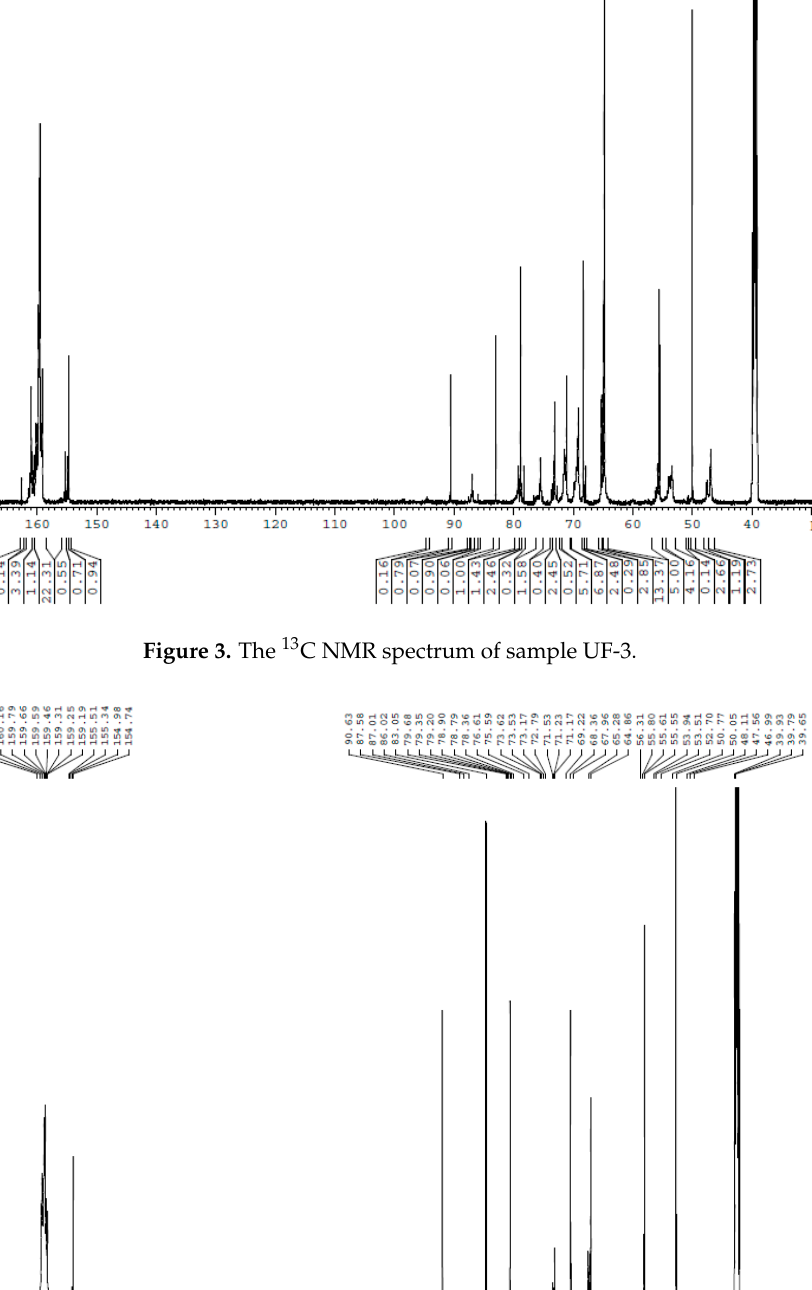
Figure 2. The 13 C NMR spectrum of sample UF-2.